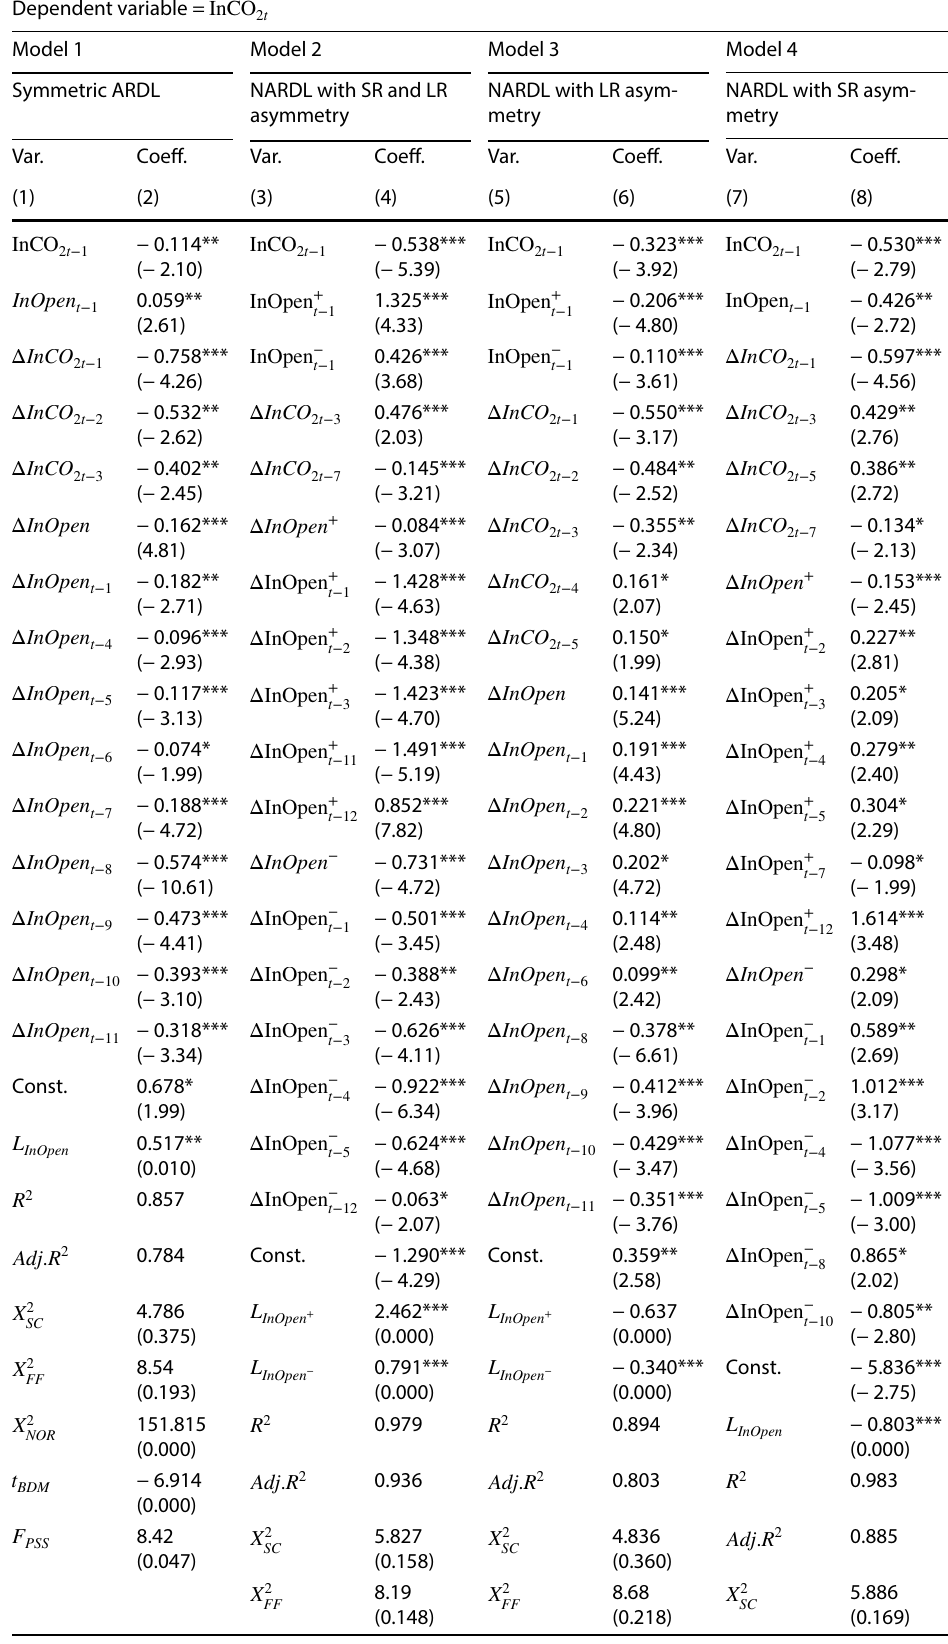
Table 7 Full-information estimates of both symmetric ARDL and nonlinear ARDL (NARDL) models in